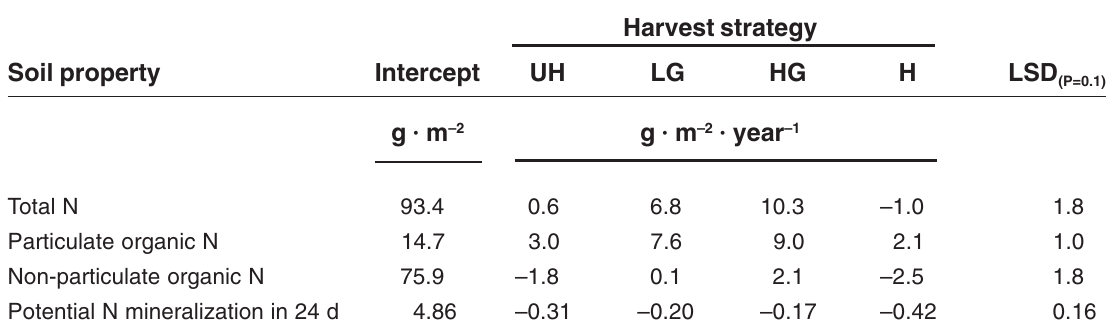
Rate of Change in Soil N Pools, Based on Linear Regression, During the First 4 Years of Management Summed to a Depth of 6 cm and in Response to Harvest Strategy Averaged across Fertilization